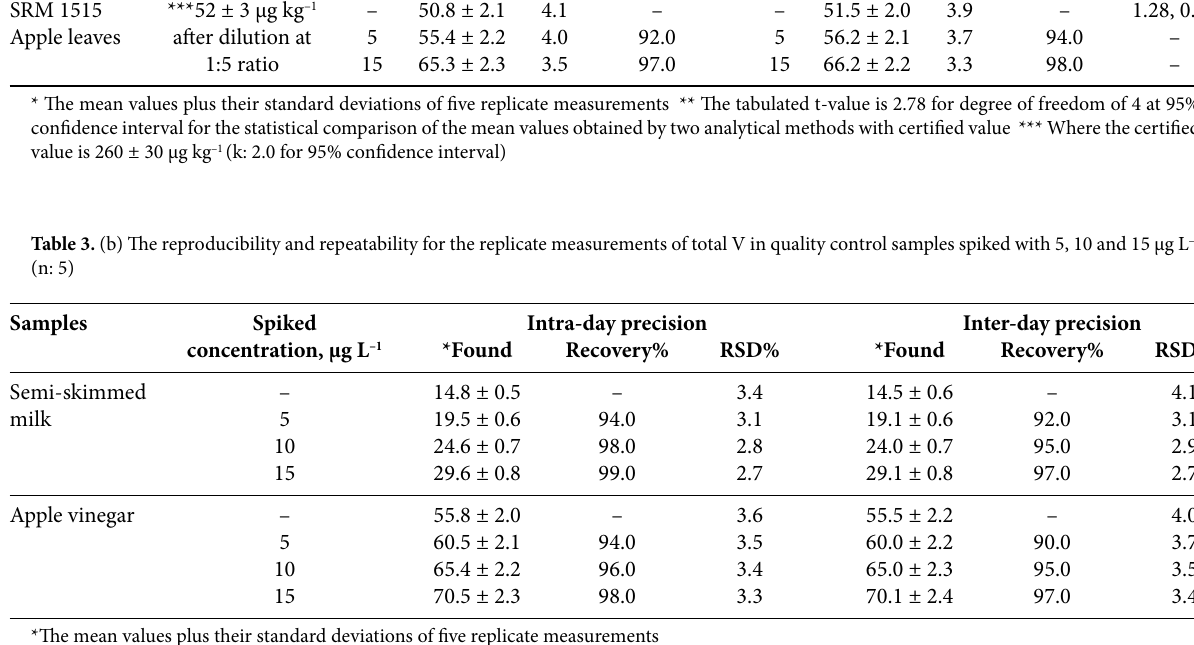
Trace elements in water Apple leaves after dilution at